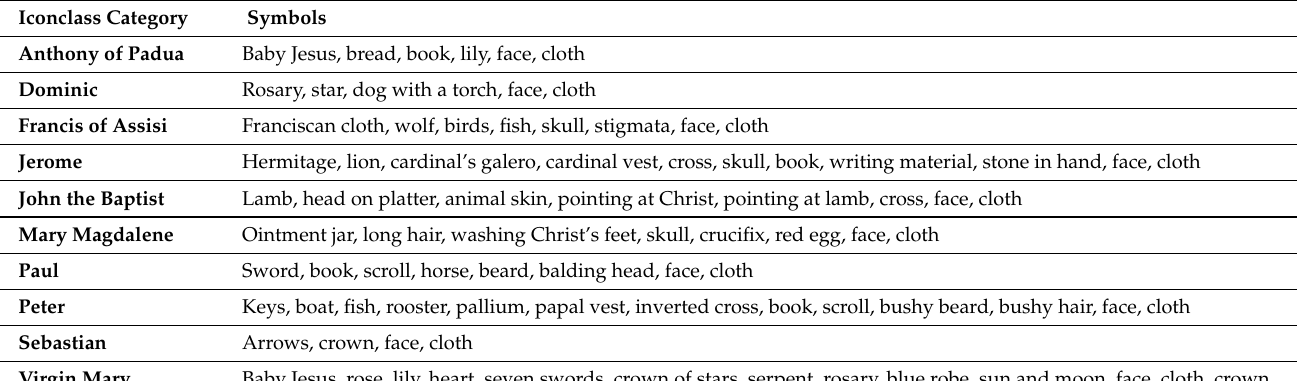
Table 1. Iconclass categories and symbols associated with